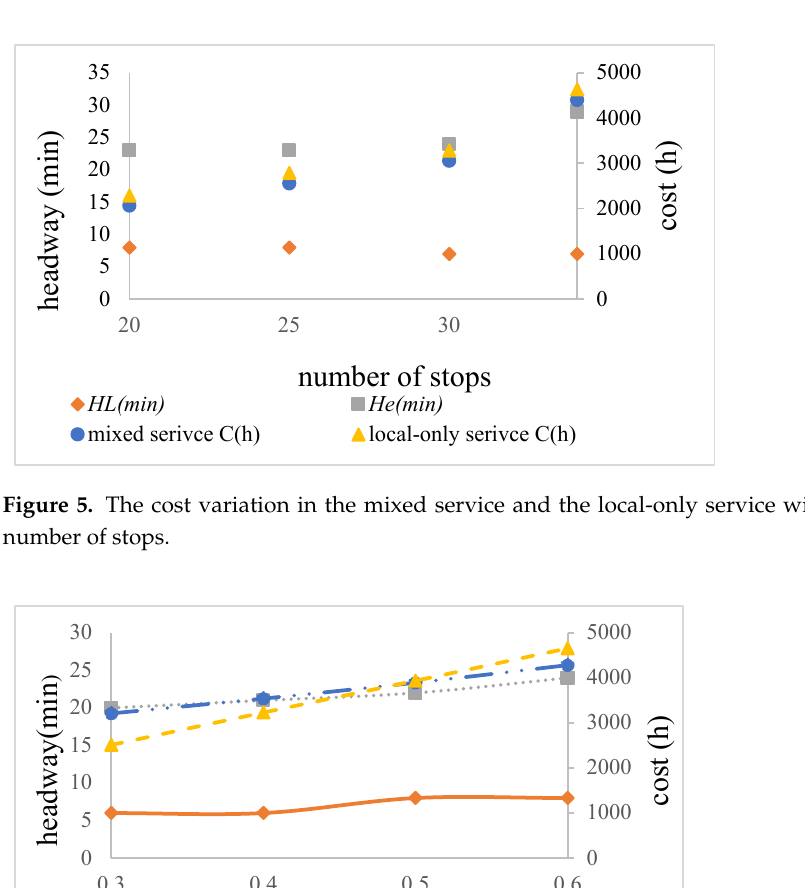
Table 5. The rates of the headway changes.